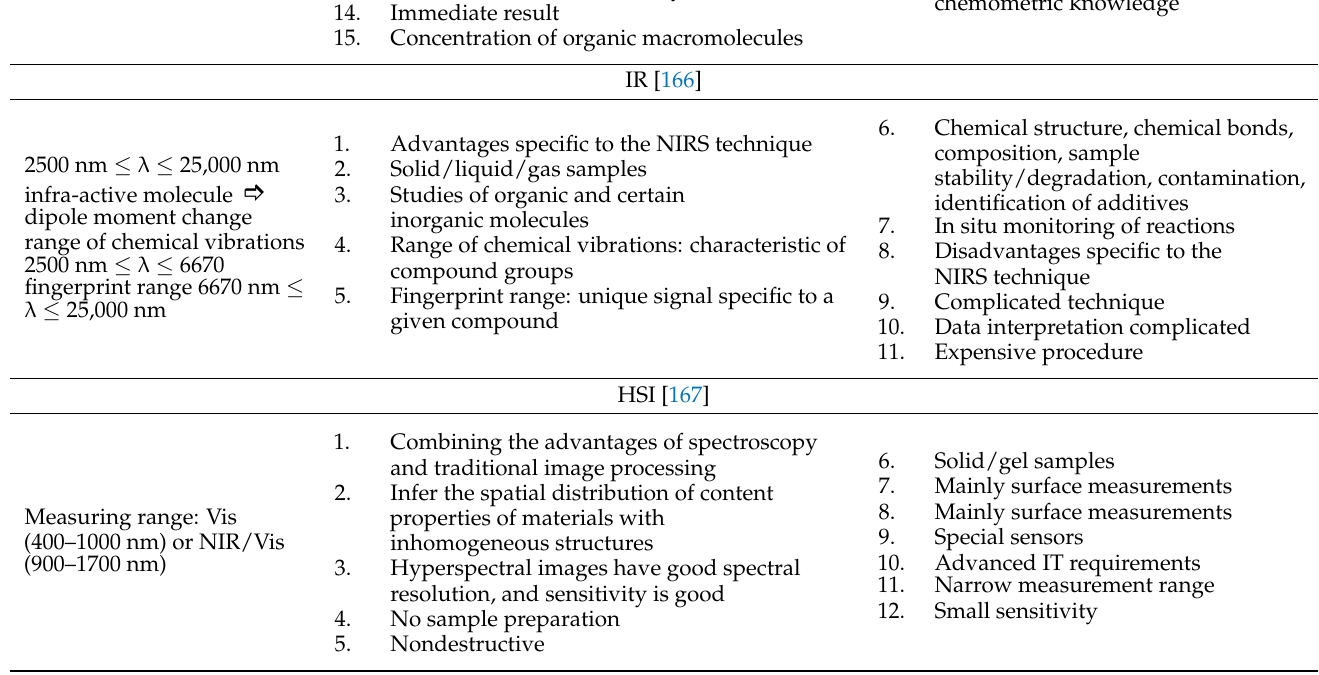
Table 2. Advantages and disadvantages of different molecular spectroscopy